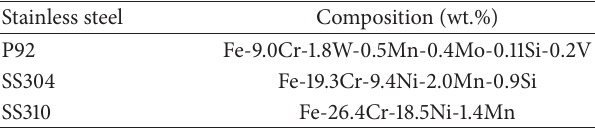
Table 1: The compositions of the three commercial stainless steels. Stainless